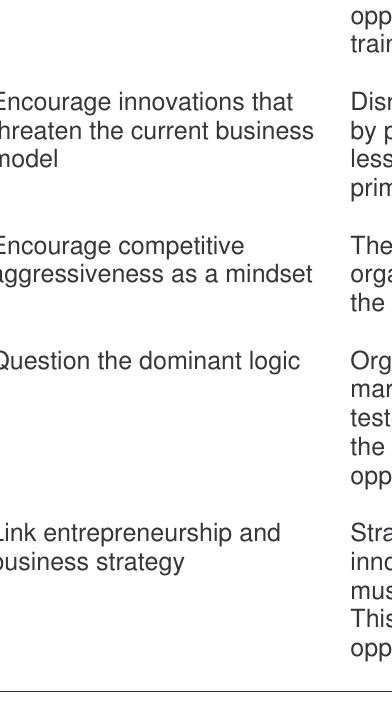
Table 1: Cultivating a strategic entrepreneurial mindset Nourish an